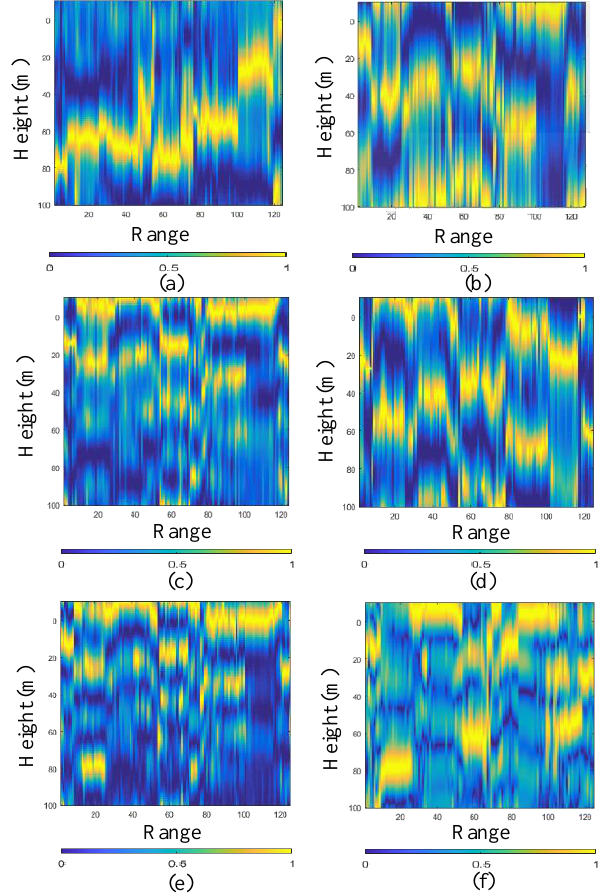
Figure 3 . Tomographic reconstruction using nonparametric spectral estimation method. (a) LP. (b) ME. (c) MN. (d) SVD. (e) Capon. (f) BF.